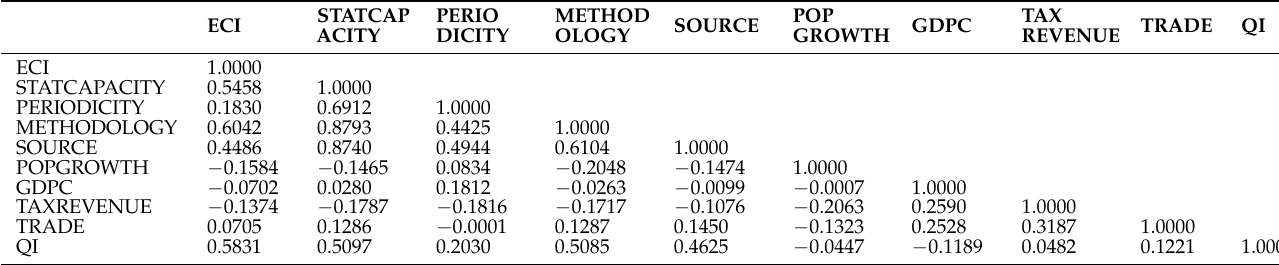
Table 3. Correlation between